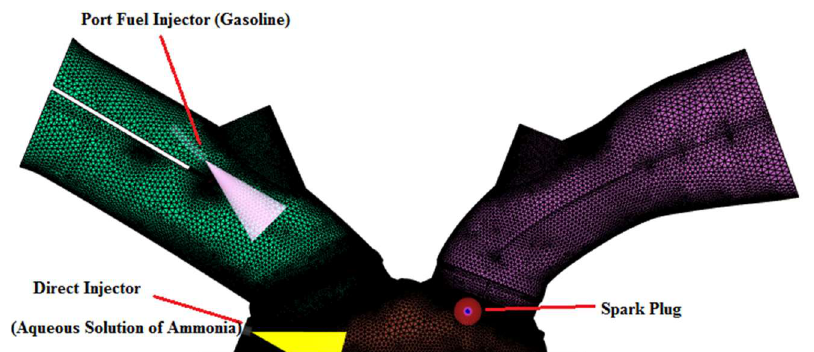
Figure 2. Relative locations of port fuel injector, direct injector, and spark plug.